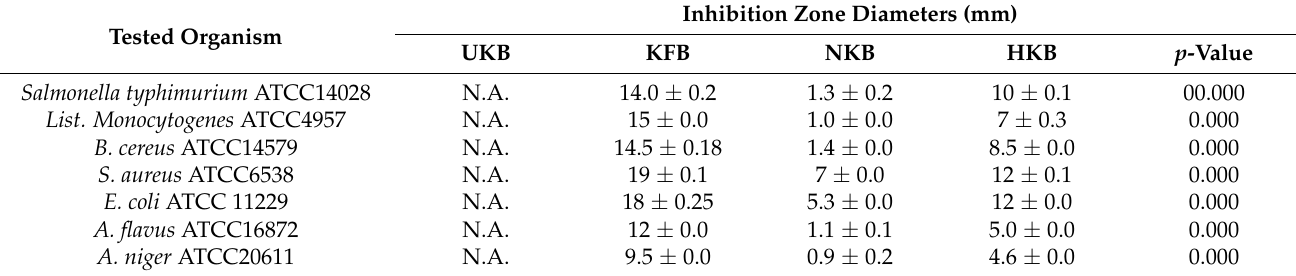
Table 2. Antimicrobial activity of unfermented, fermented, neutralized and heat-denatured kombucha determined by the agar well diffusion method. Tested